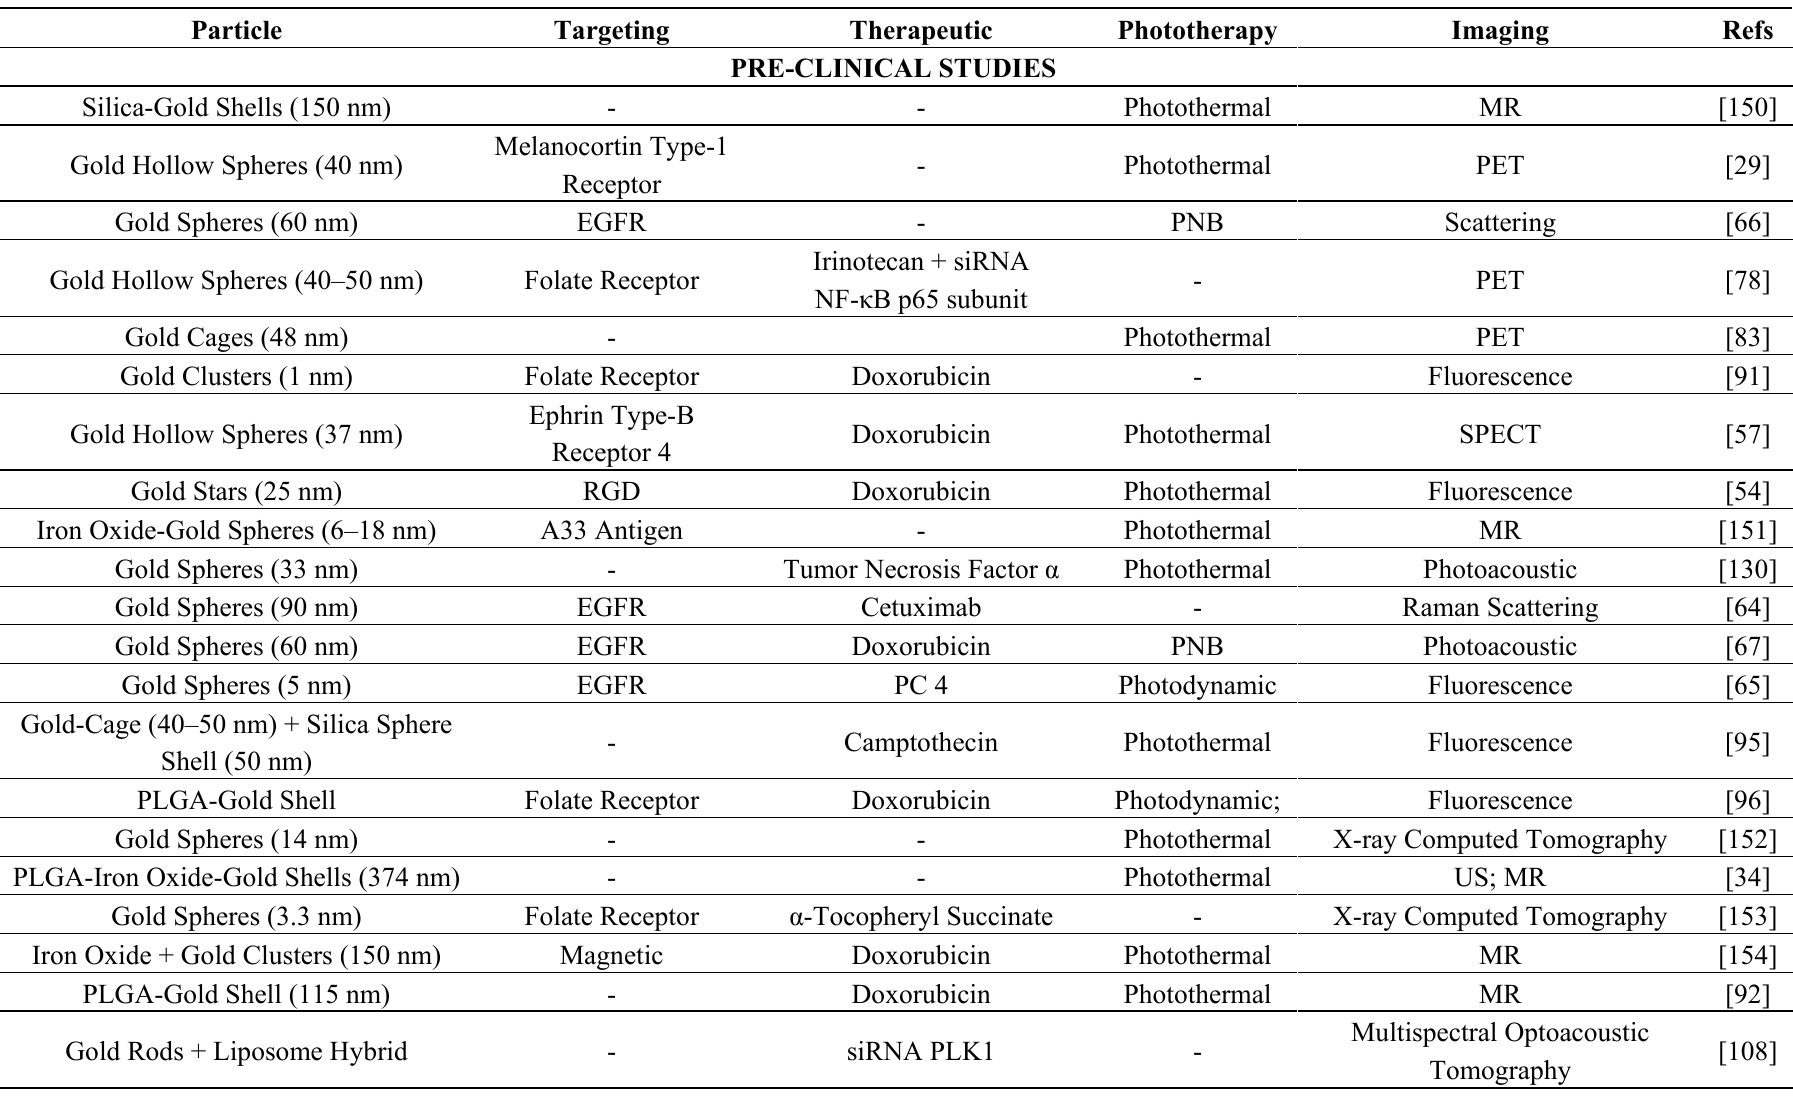
Table 1. Compilation of gold strategies. Brief overview of current efforts in AuNPs for theranostics–pre-clinical and clinical